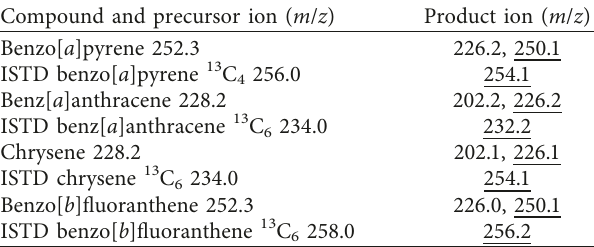
62) and (b) fish ( n 80) products. (cid:29) (cid:29) Table 1: Precursor and product ions of PAH4 compounds. Compound and precursor ion ( m / z